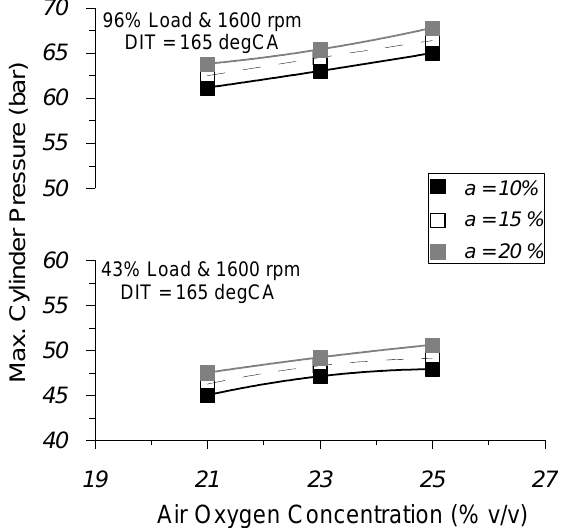
Figure 10. Calculated maximum cylinder pressure versus “inlet-air oxygen ratio” for various “diesel fuel quantity ratios”, at 43% and 96% of engine rated load and 1600 rpm engine speed, for DIT = 165